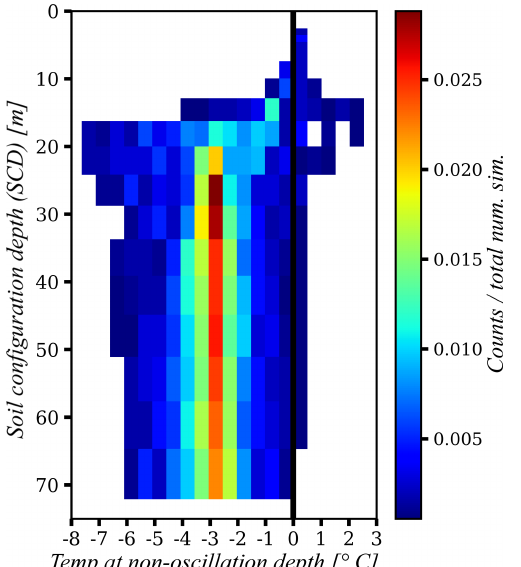
Figure 11. The 2-D histogram of SCD and temperature at h T - non-oscillation depth. Only SCDs that have reached the h T -non- oscillation condition are included. The black line represents the 0 ◦ C temperature.